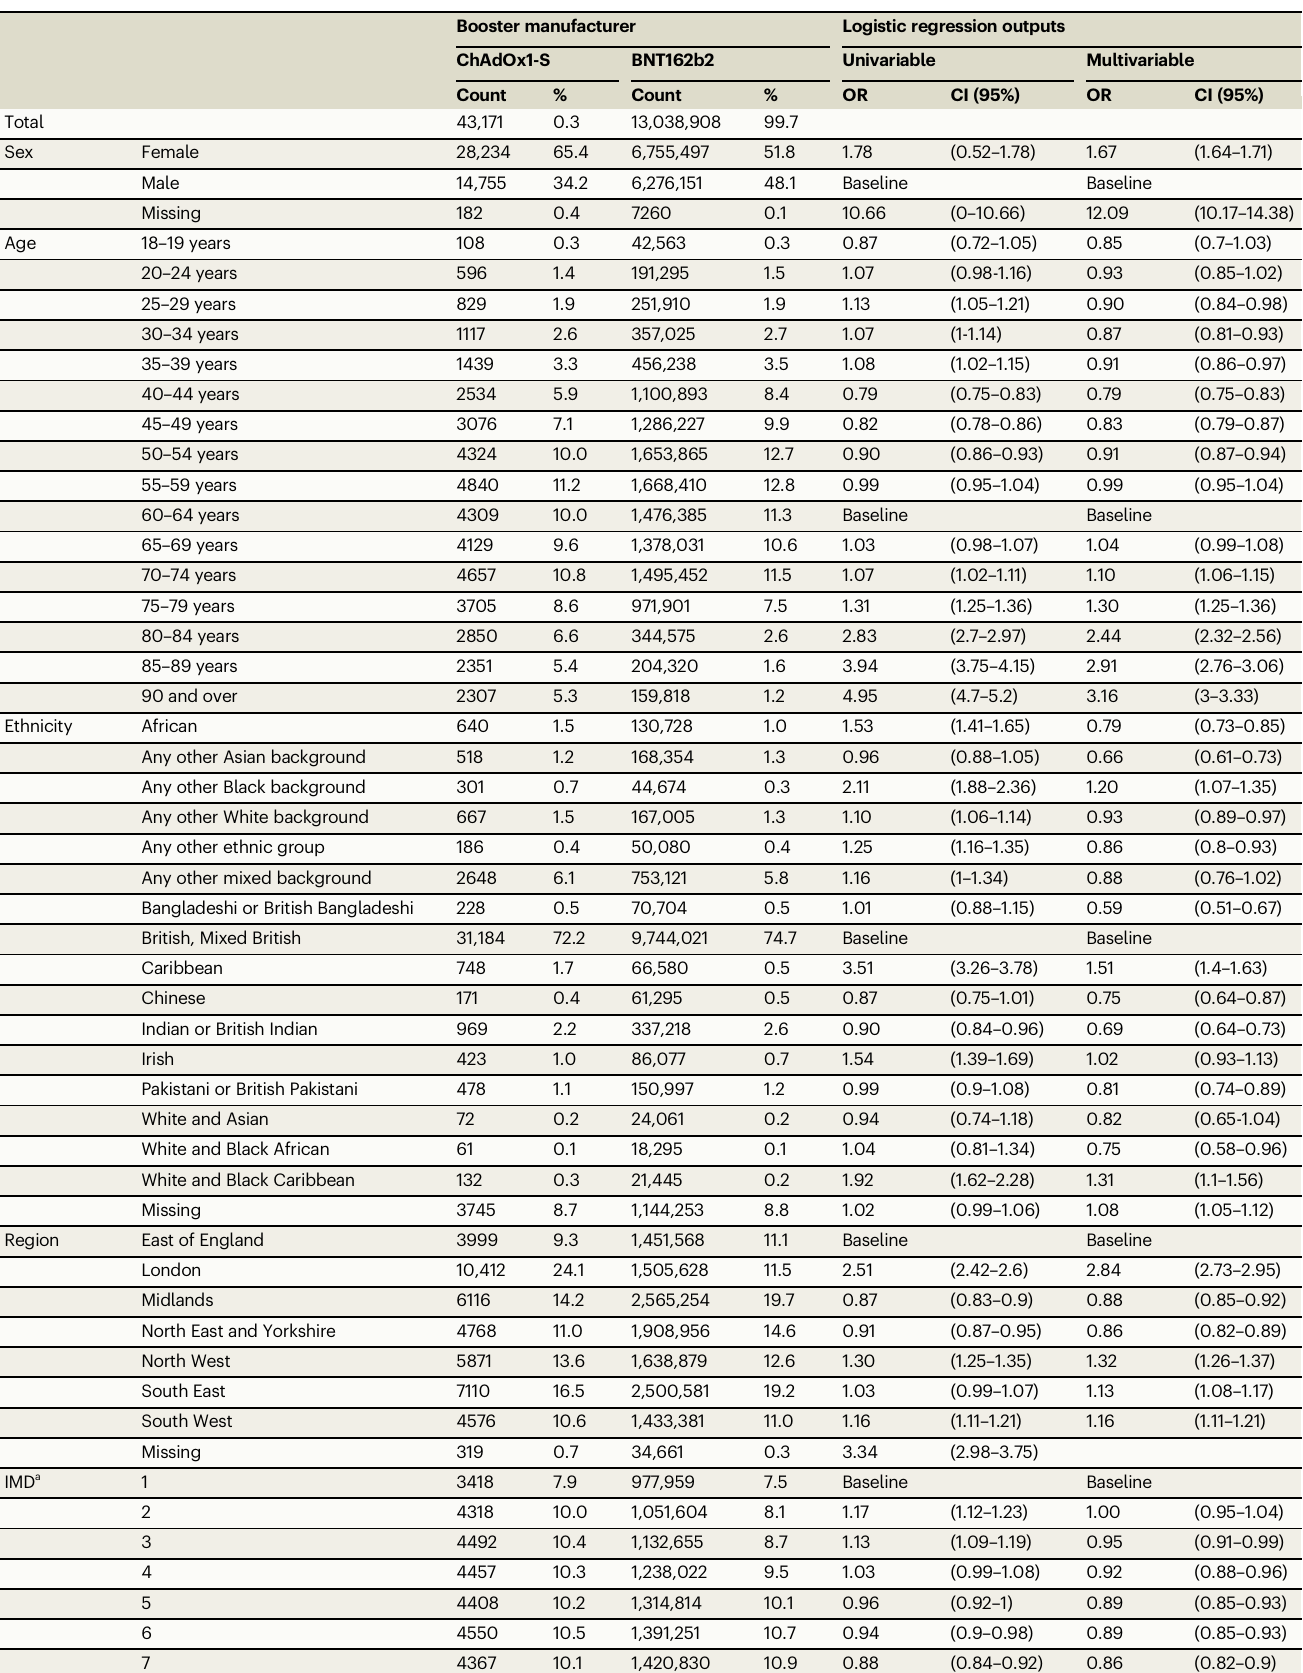
Table 1 | Demographic characteristics of the adults who received a ChAdOx1-S booster as compared to a BNT162b2 booster, following a ChAdOx1-S primary course, in